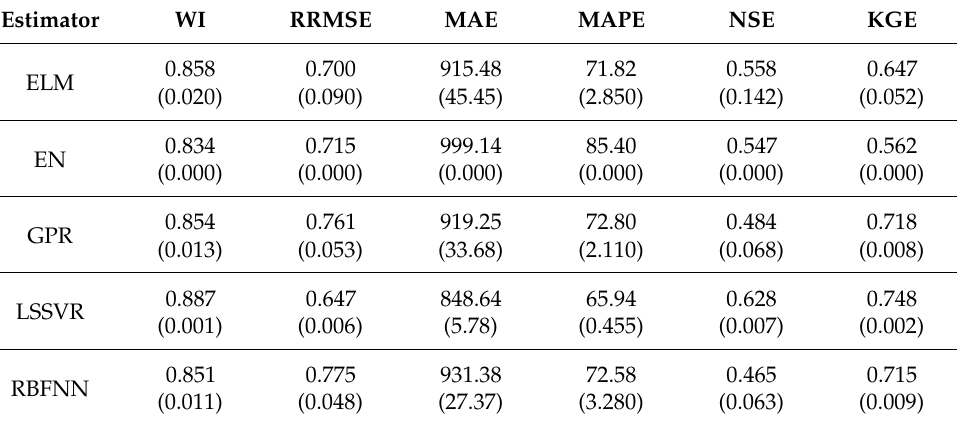
Table 11. Model results for Case